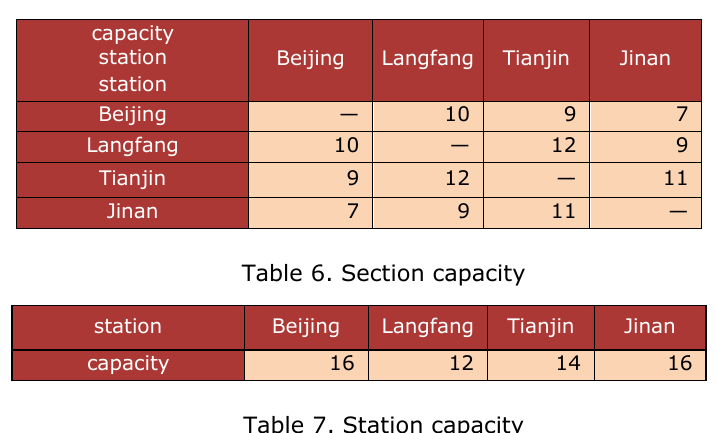
Table 7. Station capacity